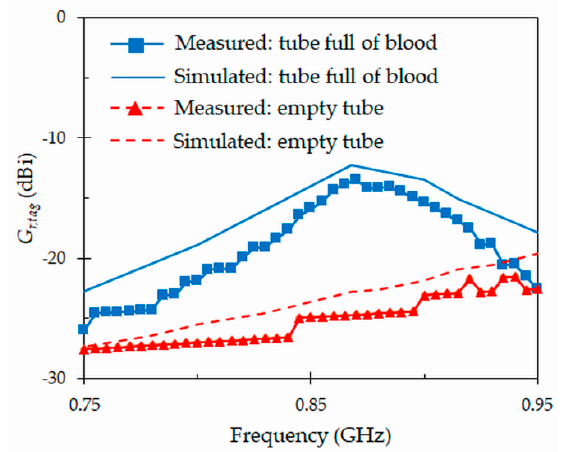
Figure 9. Simulated and measured realized gain G r,tag for the proposed tag antenna attached to full and empty blood tubes.